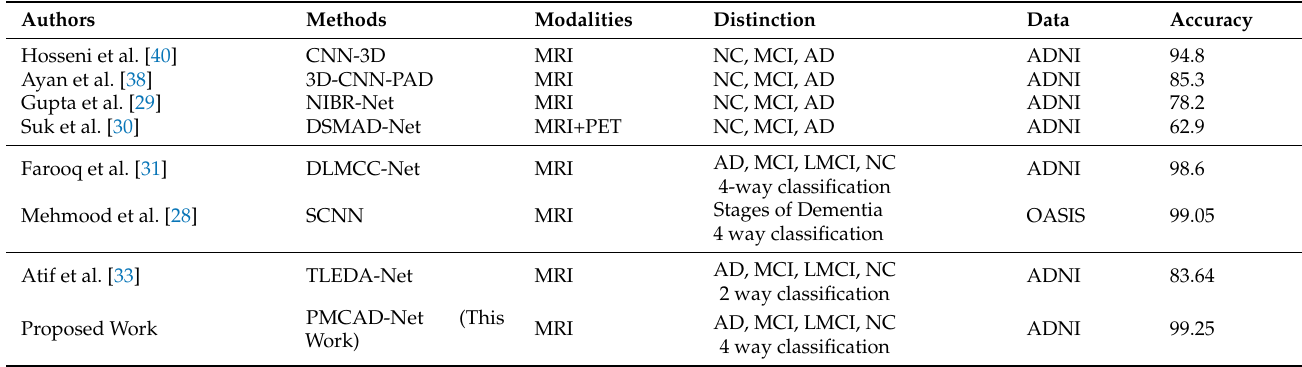
Table 3. Comparison of the accuracy of the various state-of-the-art approaches with the proposed